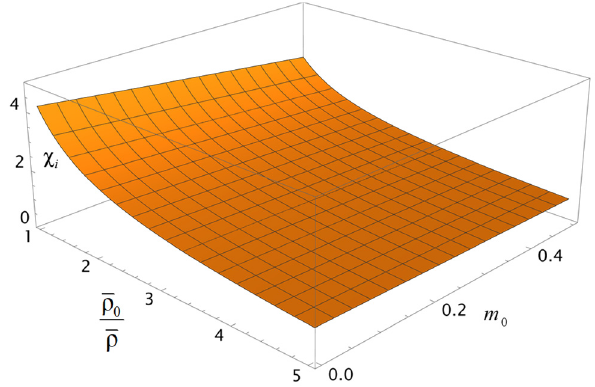
Figure 4. Dependence of the coefficient χ i on the porosity m 0 of the layer and the ratio ρ 0 / ρ of exchange capacities at s 0 = 2, C 0 / ρ = 0.1, D + / D m + = 16.4, D + = 9610 , D − = 2030 , D m + = 586 µ m 2 /s.